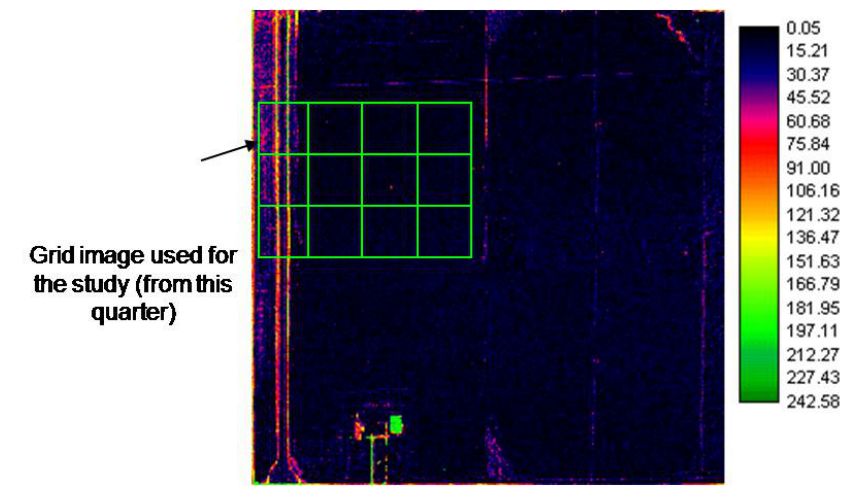
Figure 8. Perpendicular vegetation index (PVI) image of the OITA SW16 quarter of